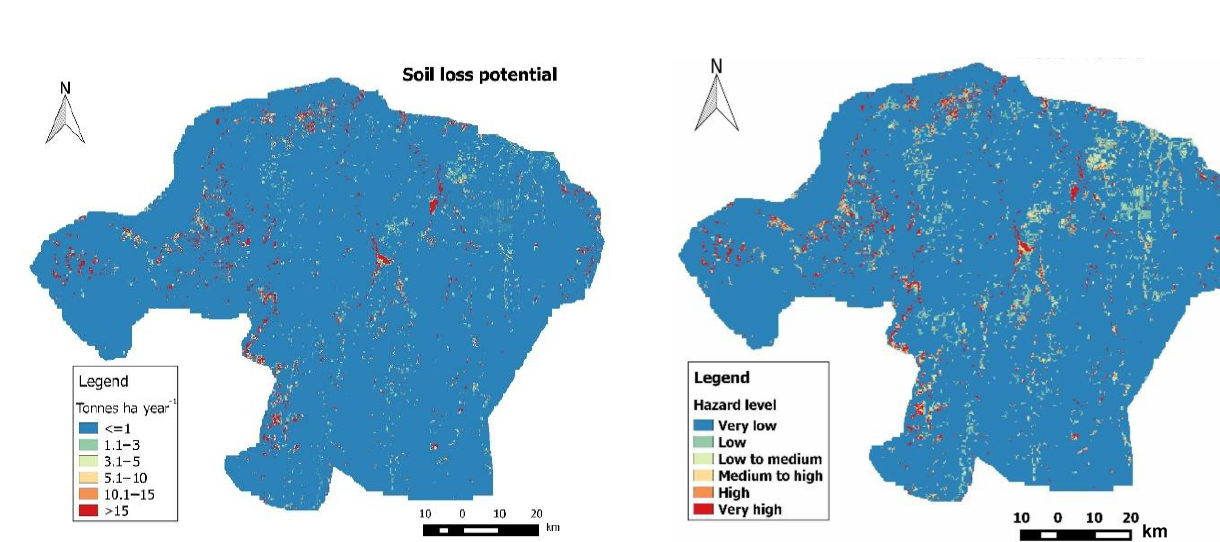
Figure 3. Histogram of erosion hazard.